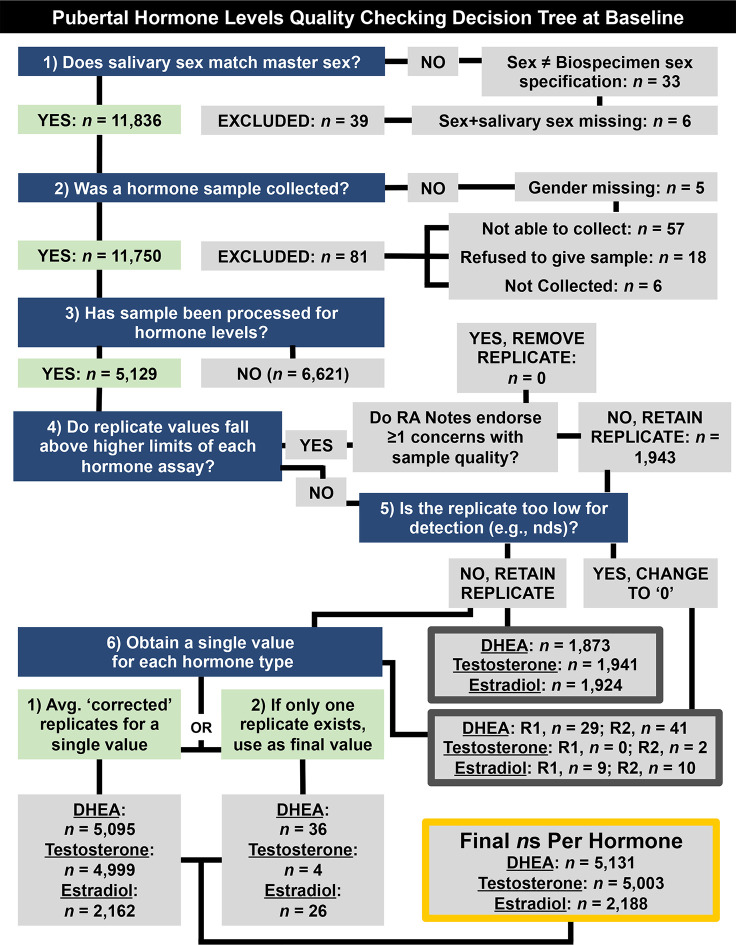
Decision tree for quality checking and generating a single hormone metric per participant at baseline (9–10 years old) (e.g., saliva assayed in duplicates, considerations for methodological concerns that may influence hormone level). Briefly, data were retained if (1) the sex specified during saliva collection matches sex at birth, as reported by parent participants, (2) if a salivary hormone sample was collected, and (3) if that sample had been processed. Replicate samples that fell below detection limits or were endorsed as problematic by research assistants (RAs) were not used to calculate participants’ hormone levels (4–6). NDS, not detectable sample; R1, Replicate 1. R2, Replicate 2.